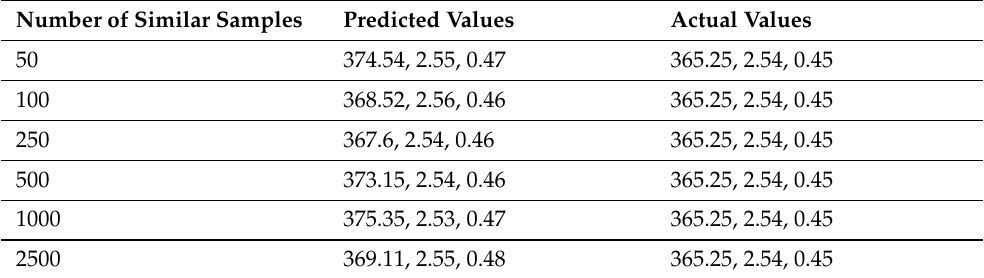
Table 10. Results for experimental unit conversion approach with 8 known traits and 100 experiments depending on the number of similar